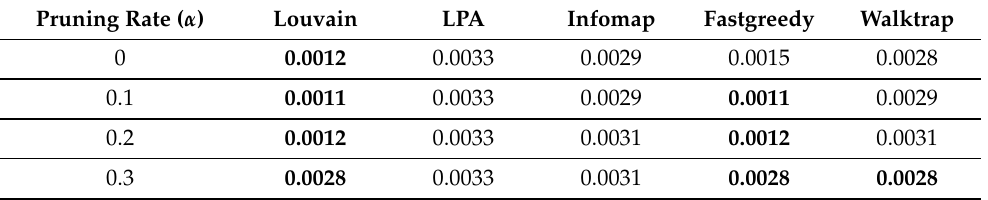
Table 5. Conductance values of clustering algorithms with various link pruning rates. Pruning Rate ( α ) Louvain LPA Infomap Fastgreedy Walktrap 0 0.0012 0.0033 0.0029 0.0015 0.0028 0.1 0.0011 0.0033 0.0029 0.0011 0.0029